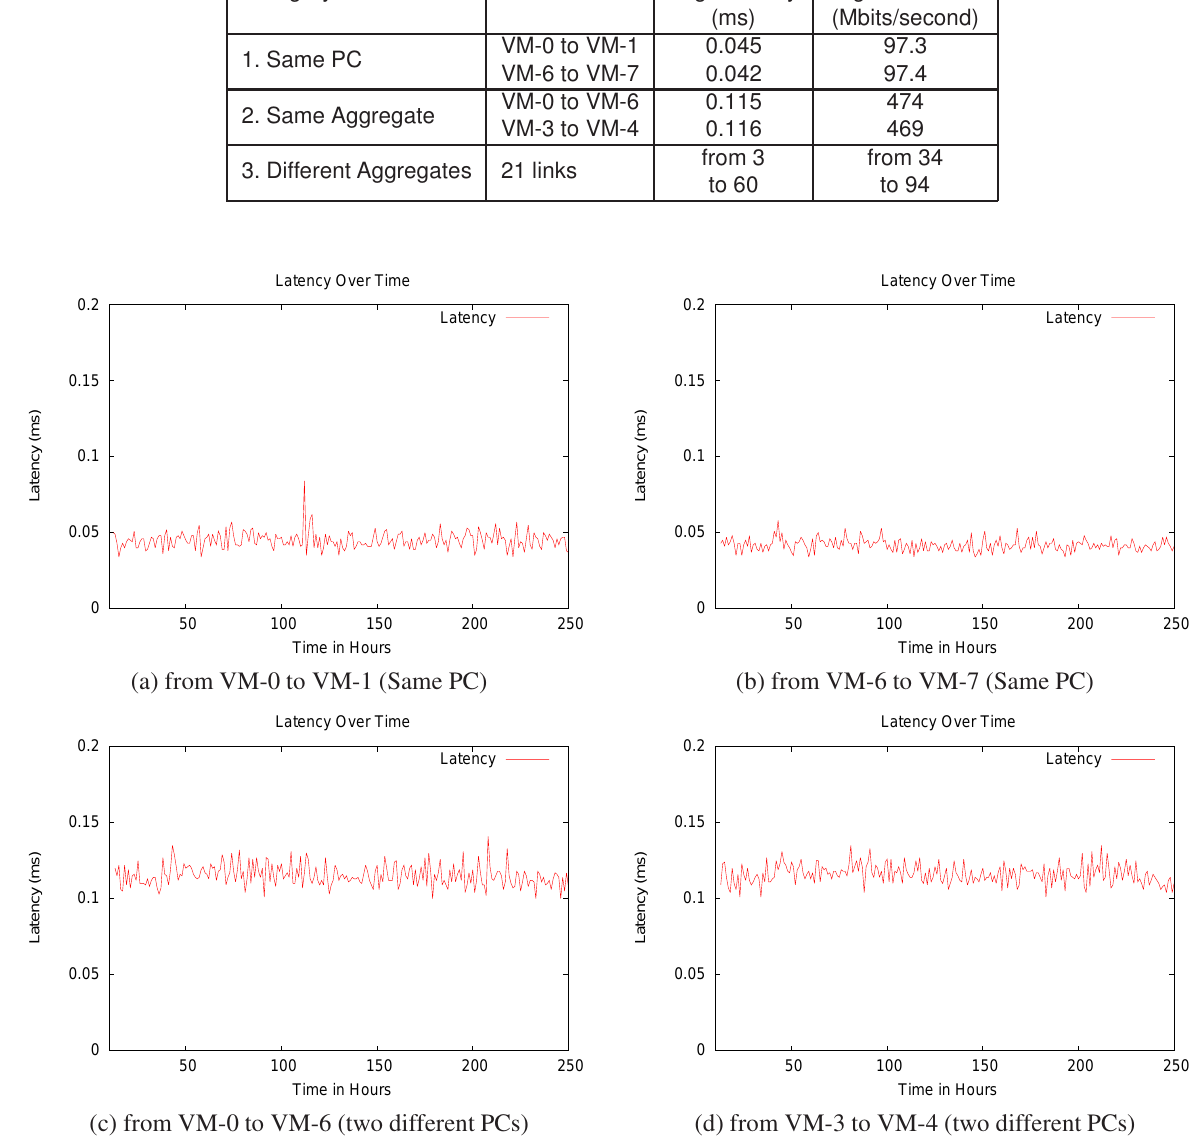
Figure 3. Latency of the links connecting two VMs from the same